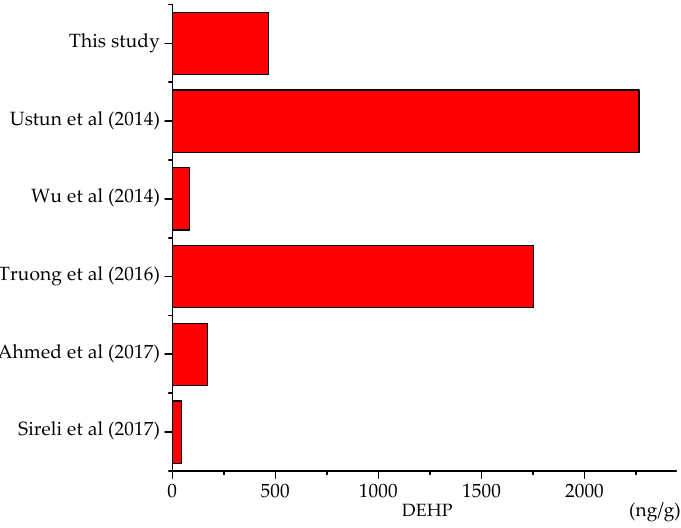
Figure 6. Concentrations of DEHP in similar studies.